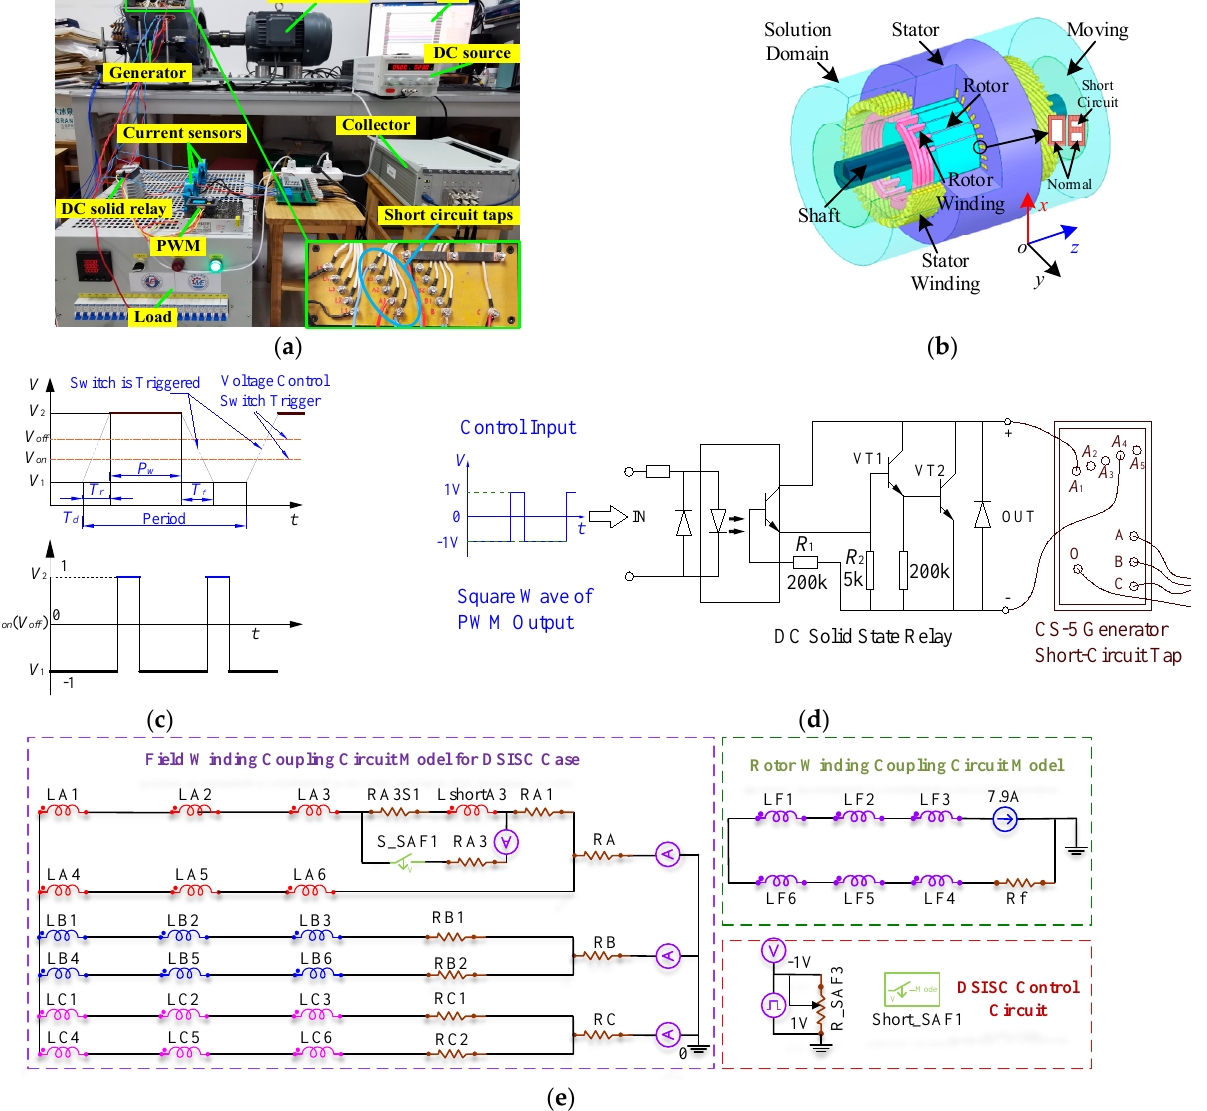
Figure 5. CS – 5 generator:( a ) picture, ( b ) FEA model, ( c ) short circuit switch control, ( d ) DSISC trigger circuit, ( e ) external coupling circuit model. circuit, ( e ) external coupling circuit